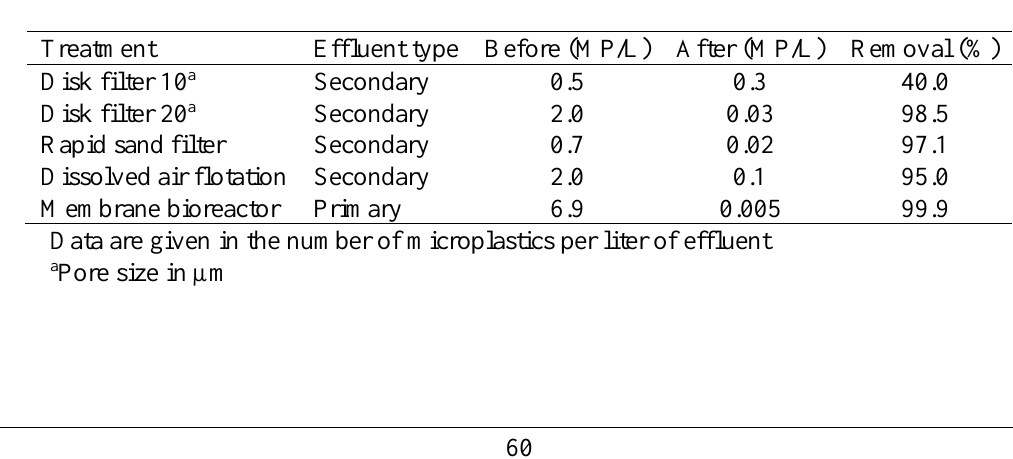
Table 3. MP removal amounts and rates in a WWTP